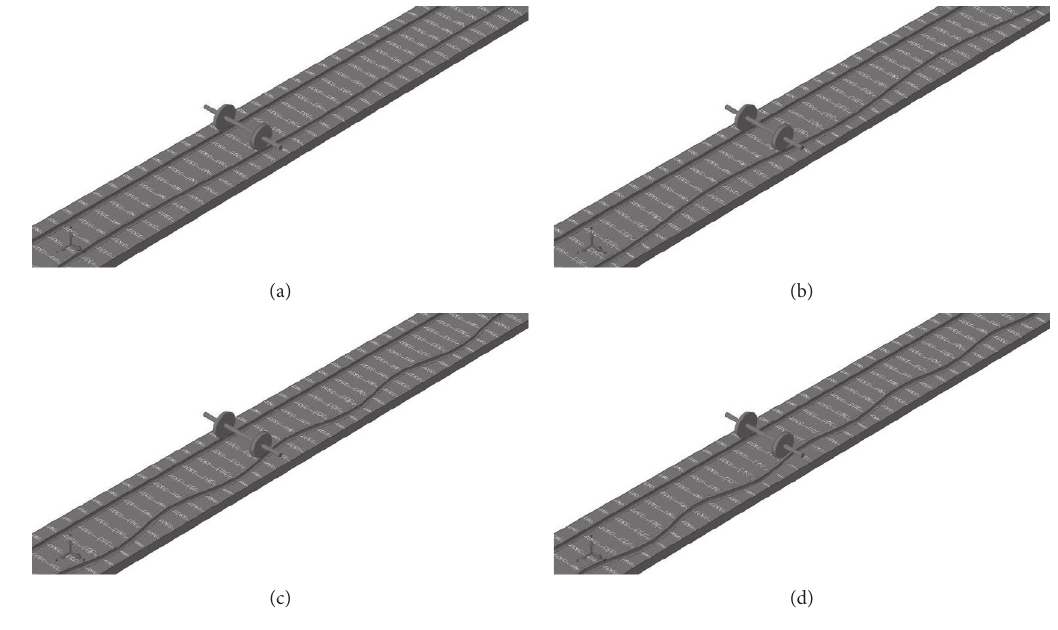
Figure 16: Mode diagram. (a) 141.7 Hz. (b) 173.8Hz. (c) 355.1 Hz. (d) 558.9Hz.